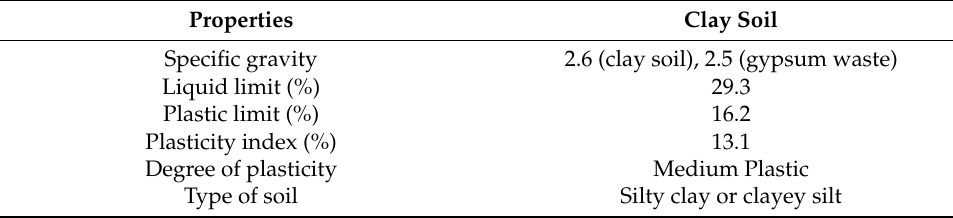
Table 3. Geotechnical